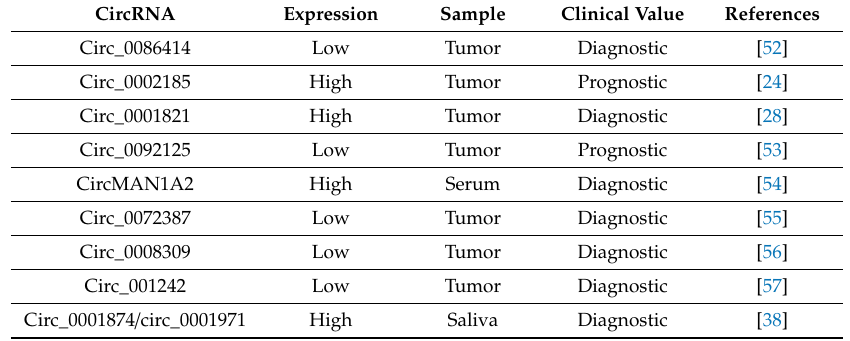
Table 3. CircRNAs reported as novel biomarkers in oral squamous cell carcinoma